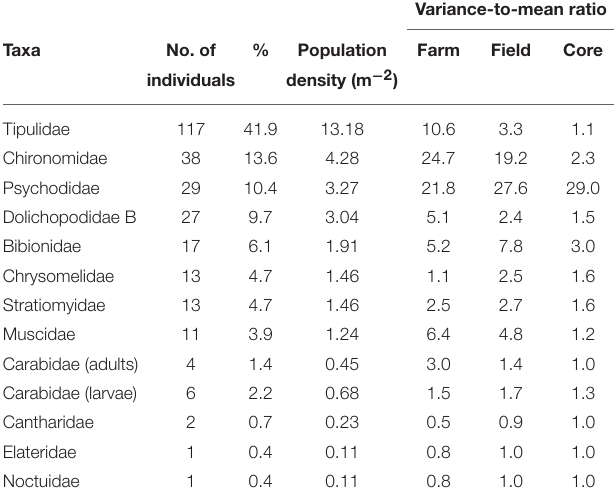
TABLE 2 | The number of individuals of each taxa, their percentage of the total 279 insects obtained from 1130 cores collected in 2013 over 19 fields in 3 farms, the population density based on an area of approximately 9 m 2 (the total area of soil cores taken from the study) and the variance-to-mean ratio for the taxa collected at the farm, field, and core scale in